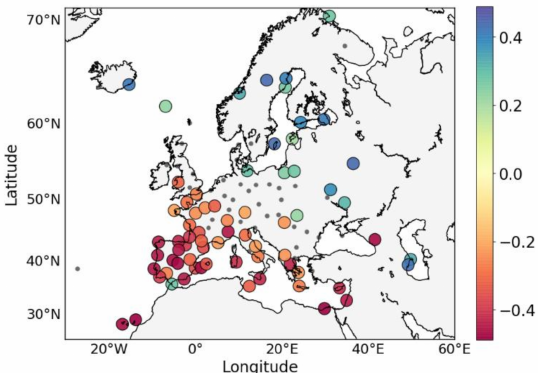
Figure 18. Spatial distribution of the correlation coefficients between the MEI and the Up coordinate time series. The Up time series were generated by using the first two components of the PCA. The grey dots represent those stations whose time series are not significantly correlated with the